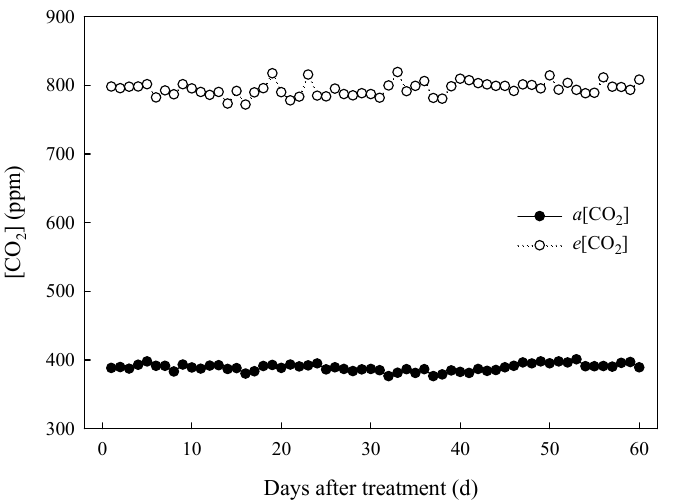
Figure 2. The actual CO 2 concentration in 400 and 800 ppm chambers during the experimental pe- riod.